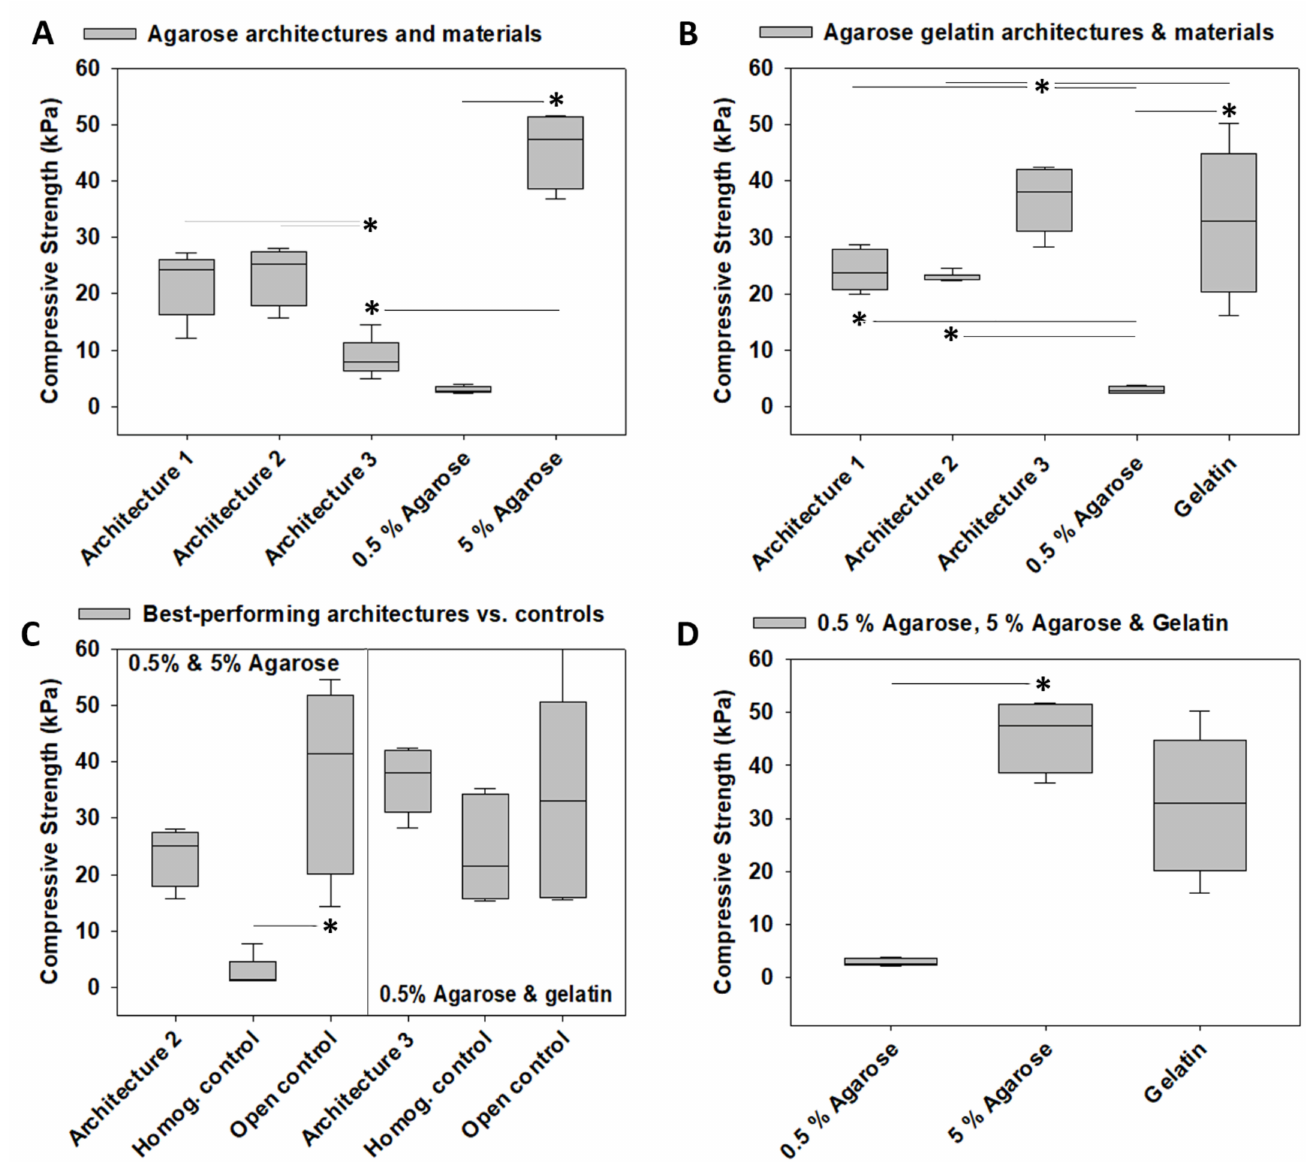
Figure 3. Mechanical characterization of the compressive strengths of the tested model systems, controls, and materials used for fabrication . ( A ) Compressive strengths of the architectures 1, 2, and 3 of the 0.5% and 5% agarose model system and of the biomaterials used for fabrication. ( B ) Compressive strengths of the architectures 1, 2, and 3 of the 0.5% agarose gelatin model system and of the biomaterials used for fabrication. ( C ) Compressive strengths of the best-performing architecture of both agarose model systems and agarose gelatin model systems determined in (A) and (B) as well as their associated homogeneously mixed controls and open controls. Those were fabricated by cutting the stiff rings of architecture 1 into pieces and distributing them within the softer biomaterial, leading to an unconfined situation. (D) Compressive strengths of all individual materials used for model system fabrication. The asterisk (*) indicates a significant difference ( p < 0.05). The box plots give the median and the 25th and 75th percentiles. The whiskers give the 10th and 90th percentiles, and the round symbols indicate outliers if present. The dark gray lines and the asterisks (*) indicate differences at p < 0.05 identified in ANOVA or ANOVA on ranks and pairwise multiple comparison procedures, such as the Newman–Keuls or Dunn’s method. Light gray lines and asterisks (*) indicate differences at p < 0.05 that were identified with the same statistical tests. Only architectures 1, 2, and 3 were compared. Number of 0.5% and 5% agarose architecture 1 model systems: n = 5, number of 0.5% and 5% agarose architecture 2 model systems: n = 4, number of 0.5% and 5% agarose architecture 3 model systems: n = 6, number of 0.5% and 5% agarose homogeneous controls: n = 5, number of 0.5% and 5% agarose open controls: n = 5, number of 0.5% agarose material samples: n = 5, number of 5% agarose material samples: n = 4, number of all 0.5% agarose and gelatin samples: n = 6